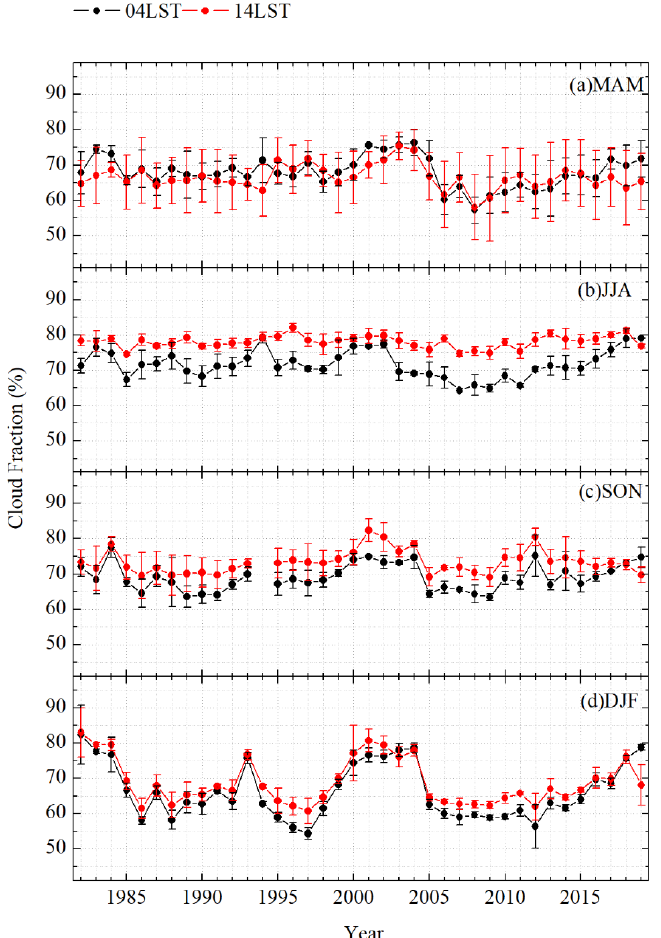
Figure 3. Time series of seasonal CF over the seas in Arctic (60~90 ◦ N) from 1982 to 2019 at 04:00 LST (black) and 14:00 LST (red). ( a – d ) MAM-DJF. Bars represent ± standard deviation of the mean in each year.